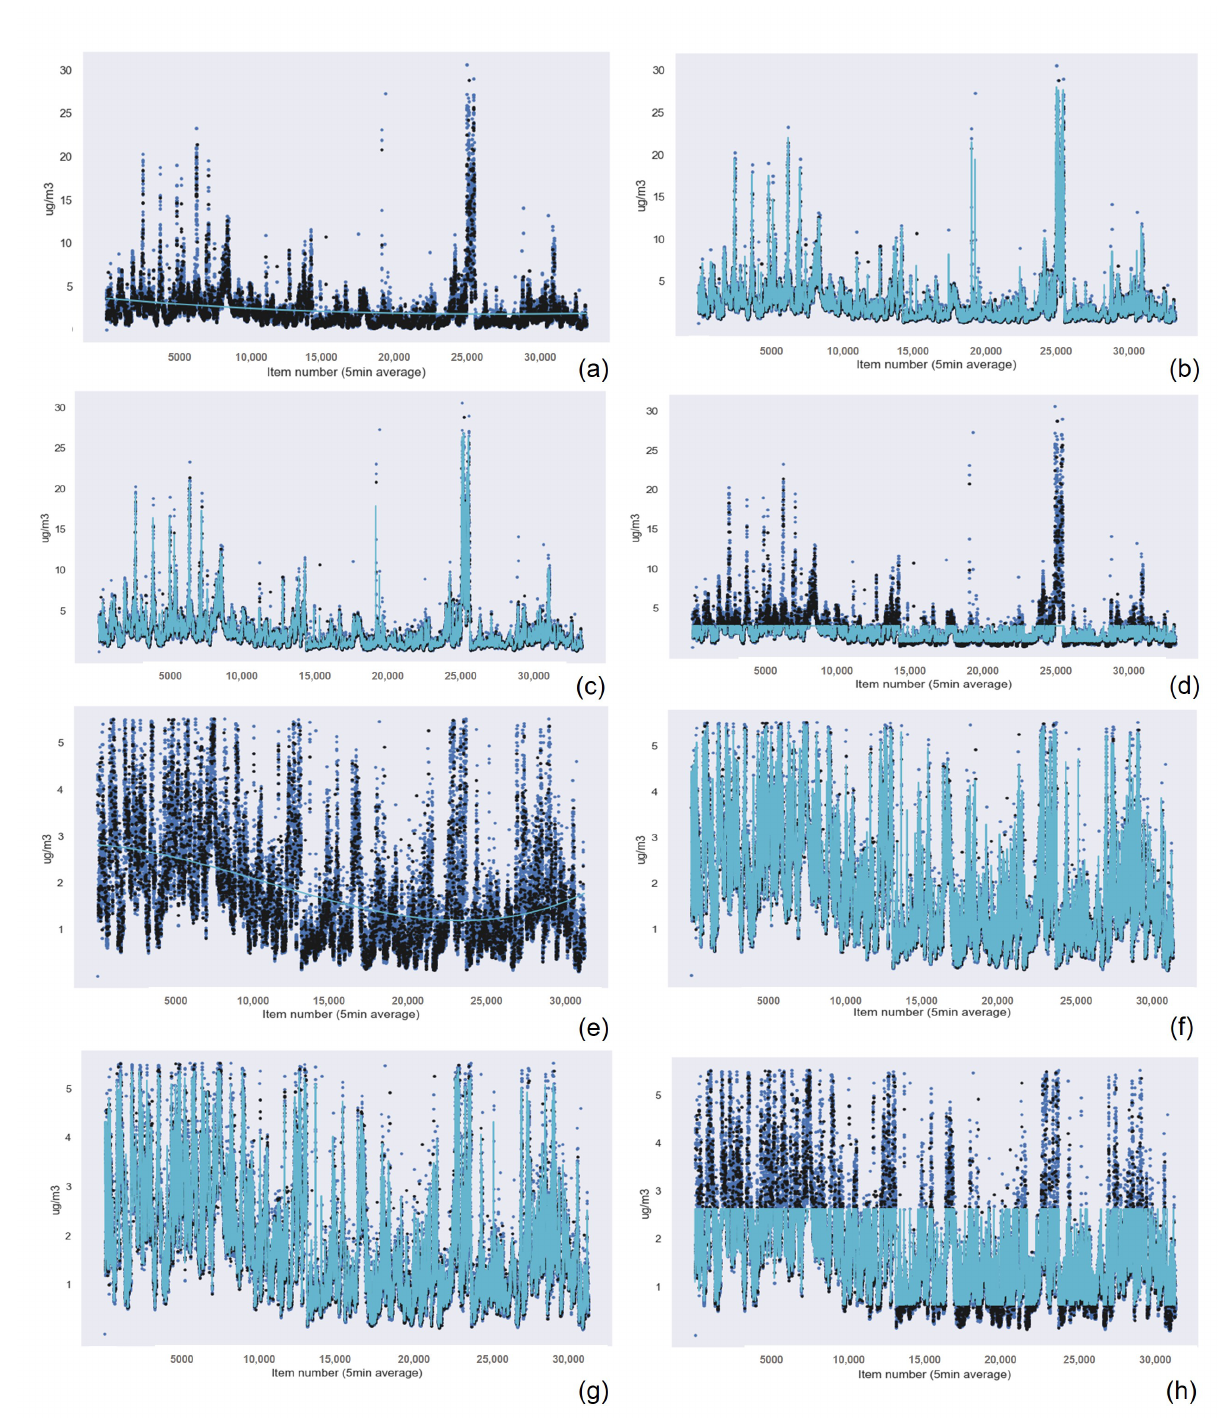
Figure A11. PM 1 results of the articulate matter measuring device # 1 with outliers for ( a ) Linear Re- gression ( b ) Random Forest Regression ( c ) KNN and ( d ) Support Vector Machine, and without outliers for ( e ) Linear Regression ( f ) Random Forest Regression ( g ) KNN and ( h ) Support Vector